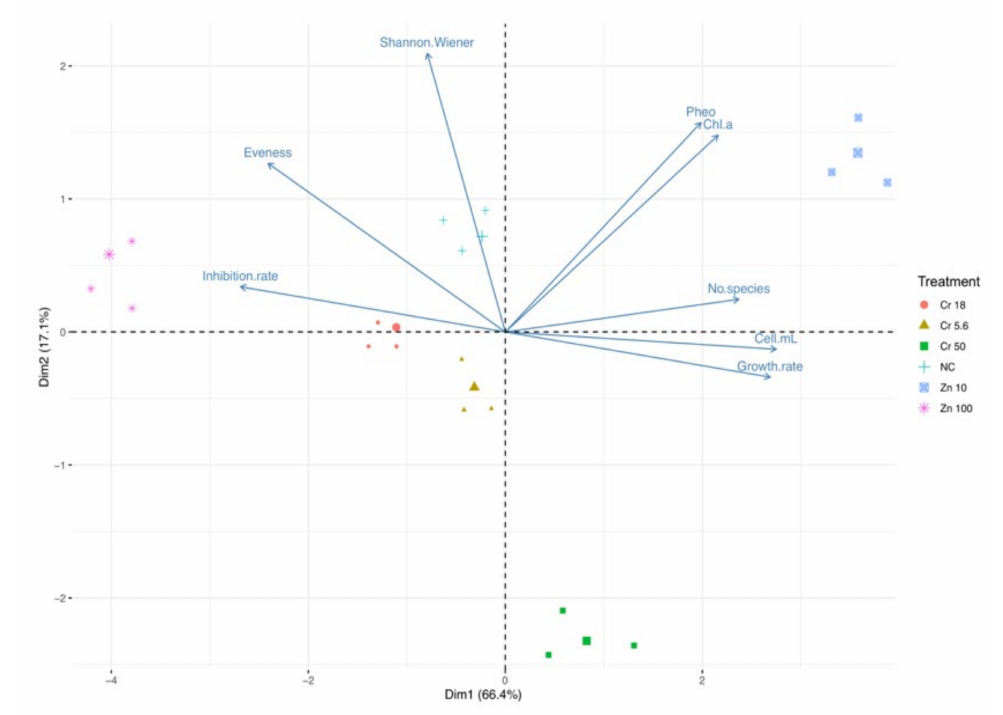
Figure 4. Principal component analysis. Trend in ecotoxicological indexes (pheophytin-Pheo, chlorophyll- a –Chl- a , inhibition rate, evenness index, Shannon–Wiener index, inhibition rate, growth rate, number of species, cell density–cell/mL across treatments (zinc oxide nanoparticles–Zn and potas- sium dichromate–Cr) in brackish water phytoplankton community (largest symbol = average